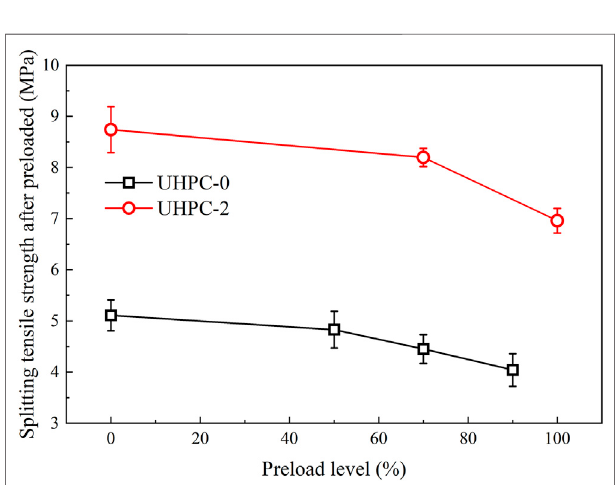
FIGURE 3 | Splitting tensile strength of unhealed specimens under different preload levels.